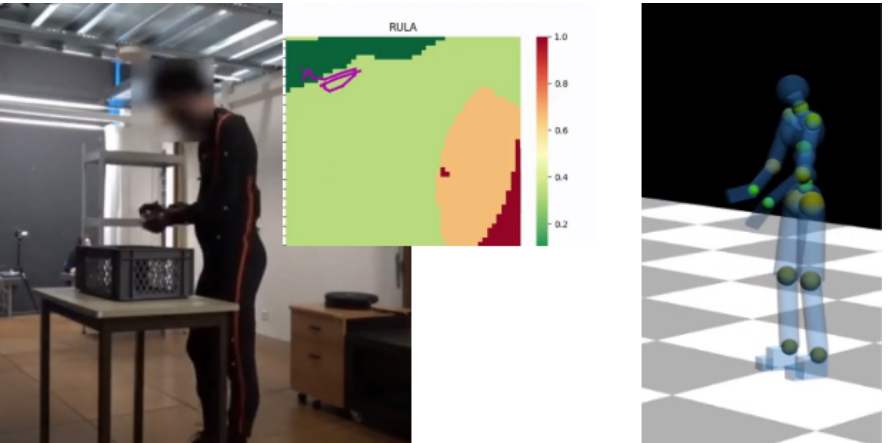
Figure 1. The ergonomics visual feedback tools used to measure the executed motion in real-time. ( Left ): the human movement is tracked with the Xsens MVN motion tracking suit. At the same time the RULA Latent Ergonomics Map is calculated, with the visualization of the current human movement (the magenta-colored line). ( Right ): the DHM with colored spheres showing the RULA scores at relevant body locations.